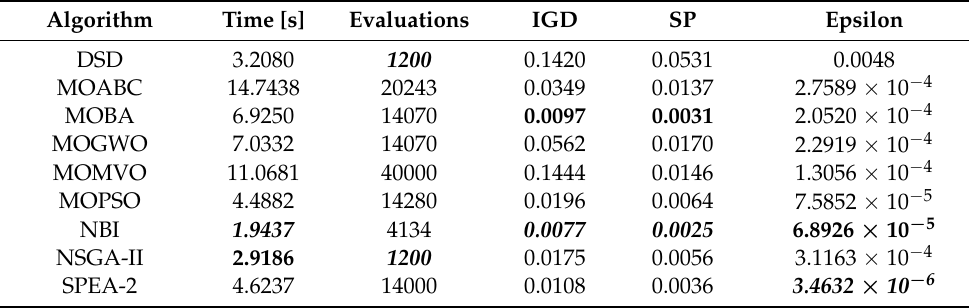
Table 2. Summary of values provided by indicators on optimization